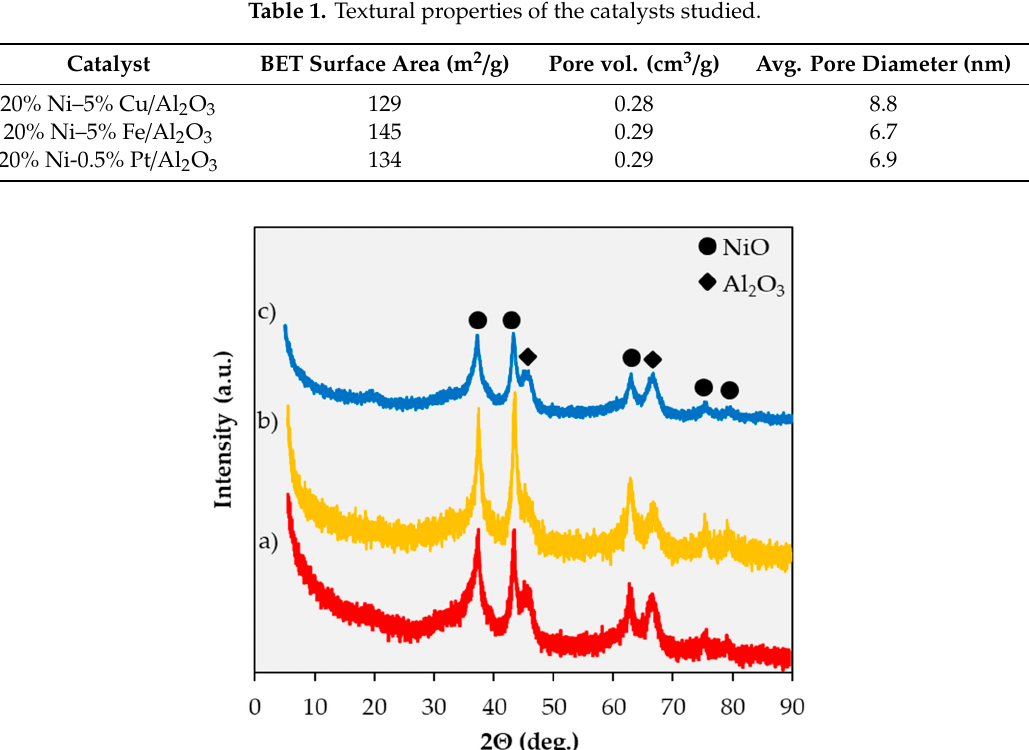
Table 1. Textural properties of the catalysts studied.